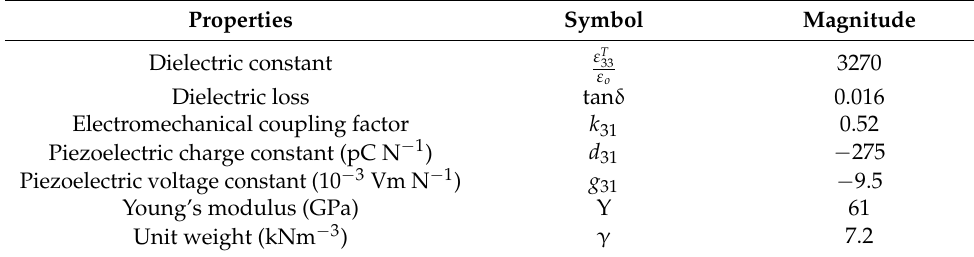
Table 2. Properties of the PZT patch.